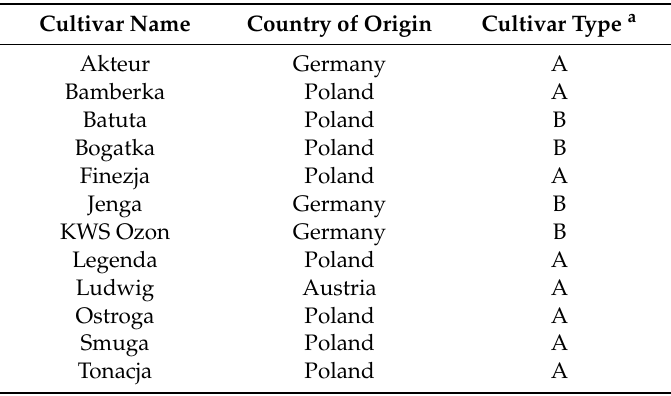
Table 1. Characteristics of the